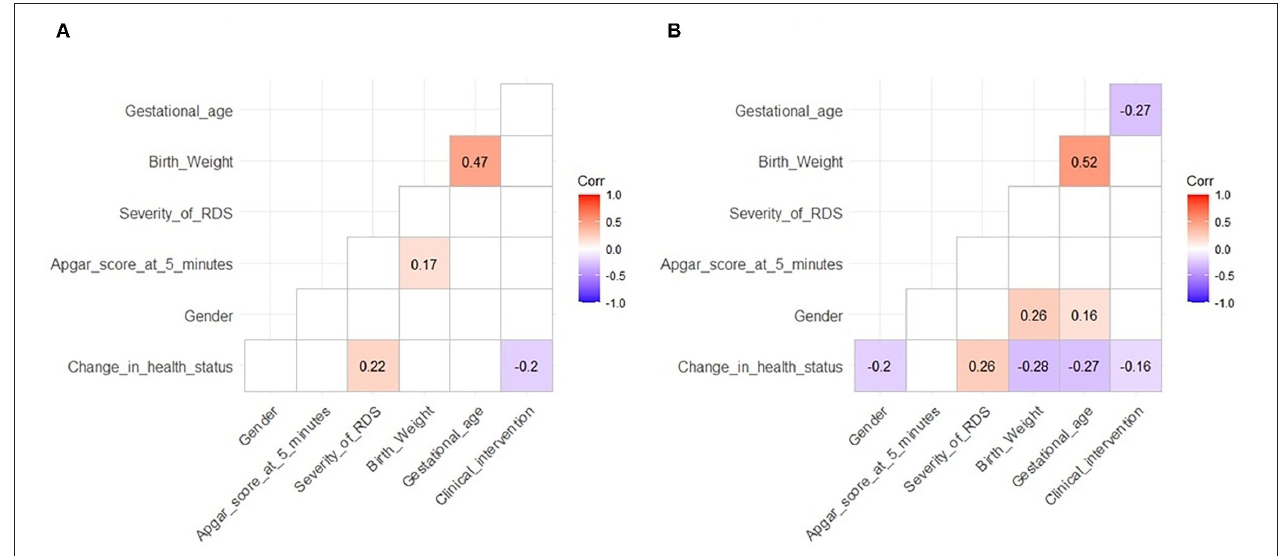
FIGURE 3 | Correlation between various indicators. (A) High altitude and (B) ultra-high altitude. Correlation coefficients were calculated before correlation tests. Blue indicates significant negative correlations and red significant positive correlations. The darker the color, the more significant. Unrelated situations are not shown. The level of significance is 0.05.